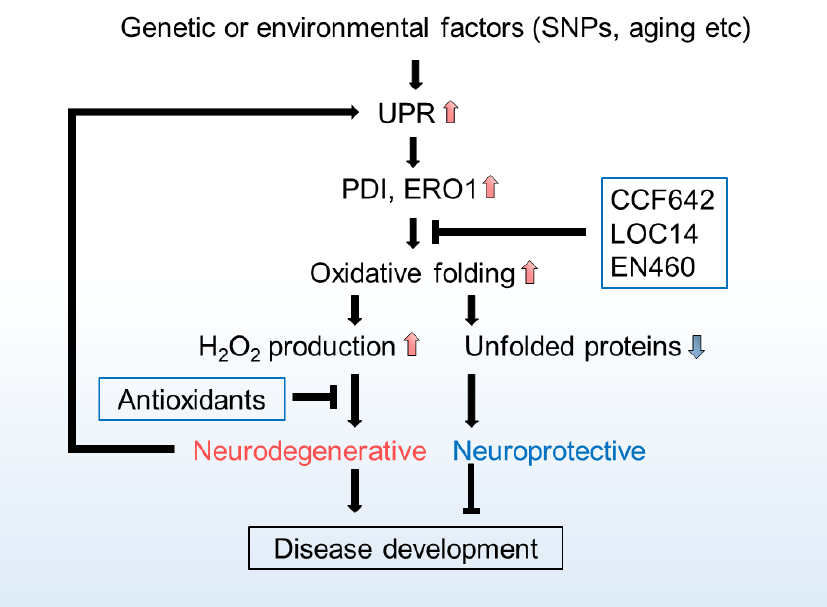
Figure 2. Schema of unfolded proteins response (UPR)-induced neurodegeneration and potential therapeutic strategies. UPR activated by a variety of factors, such as single nucleotide polymorphisms (SNPs) as genetic factors and aging or metabolic dysfunction as environmental factors, augments the expressions of target genes such as PDI and ERO1, and enhances the oxidative folding capacity of the ER. This can reduce the accumulation of unfolded proteins and results in neuroprotection, whereas excess H 2 O 2 , which is concomitantly produced by this process, exacerbates neurodegeneration as an oxidative stress agent. Inhibitors against PDI or ERO1 (such as CCF642, LOC14, and EN460) and antioxidants are considered promising in mitigating the development of neurodegenerative pathology by reducing ER-derived H 2 O 2